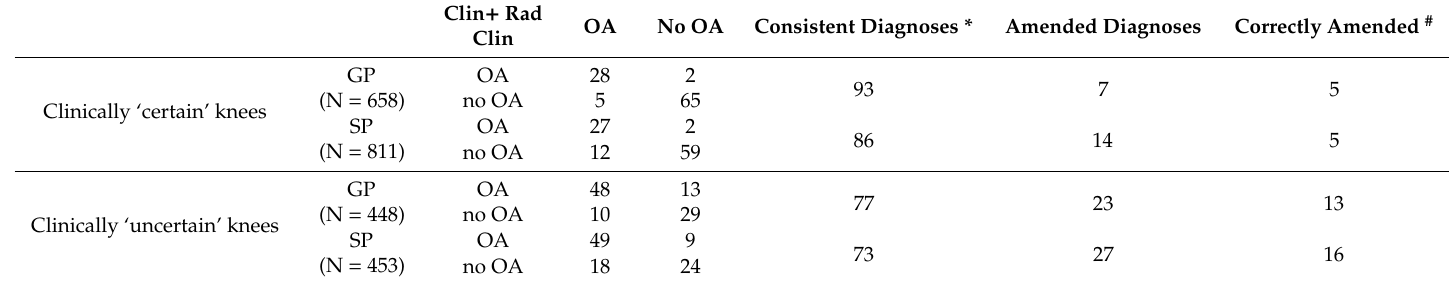
Table 4. Final diagnoses and rate of amendment split by certainty of initial clinical diagnosis (% of patients of each subgroup).